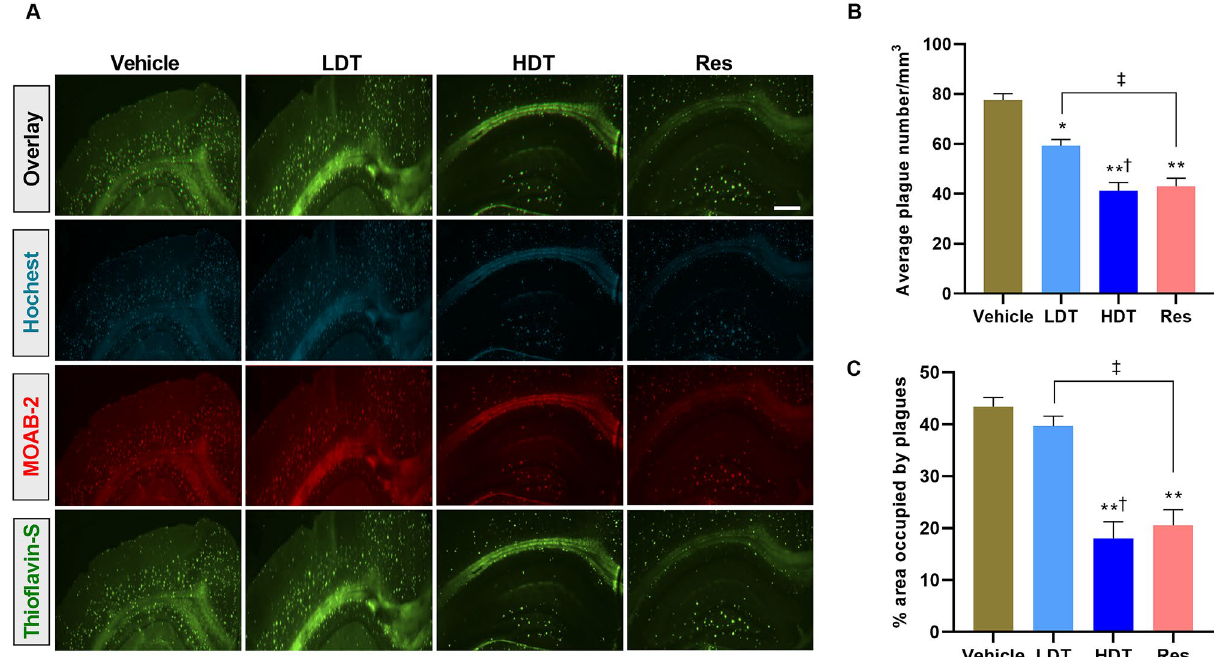
Figure 5. Confocal microscope immunoreactive studies to examine Aβ plaque deposition in the hippocampus region of 4-month-old 5xFAD mice brain after 45 consecutive days (P30-75) treatment with W. somnifera . ( A ) Representative images at × 100 of combined immunofluorescence and Thioflavin-S staining of the mice brain coronal sections, scale bar = 500 μm. ( B ) Quantification of the average number of Aβ plaque deposition. ( C ) Percentage of the area occupied by the plaques. The data represent the mean ± SEM. Data were from 4 different mice in each group (n = 4 of two independent sessions) using one-way ANOVA followed by Tukey’s multiple comparisons test. Significance is indicated by * p < 0.05; ** p < 0.01 versus vehicle; by † p < 0.05 between W. somnifera treated groups; by ‡ p < 0.05 between W. somnifera and Res treated groups. Vehicle control group, LDT low dose treatment, HDT high dose treatment, Res Resveratrol.